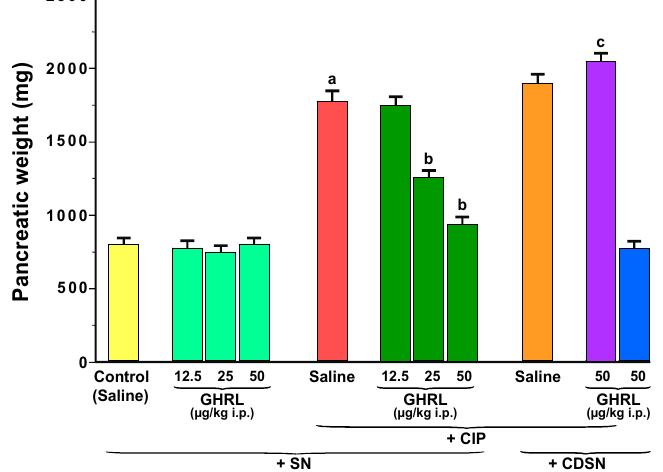
Figure 1. Effect of saline or ghrelin (GHRL) given intraperitoneally at a dose of 12.5, 25 or 50 μ g/kg and cerulein-induced pancreatitis (CIP) on pancreatic weight in sensory nerves-intact rats (SN) or rats with capsaicin deactivation of sensory nerves (CDSN). a p < 0.05 compared to the control group with intact sensory nerves and without induction of CIP; b p < 0.05 compared to sensory nerves-intact rats with CIP pretreated with saline; c p < 0.05 compared to sensory nerves-intact rats pretreated with GHRL at a dose of 50 μ g/kg prior to CIP. Mean ± standard error of the mean (SEM) from values obtained from 10–15 rats in each experimental group. Table 1. Effect of saline or ghrelin (GHRL) given intraperitoneally at increasing doses of 12.5, 25 or 50 μ g/kg on morphological changes of pancreatic tissues in the course of cerulein-induced pancreatitis (CIP) in animals with intact sensory nerves or with capsaicin deactivation of sensory nerves. Groups